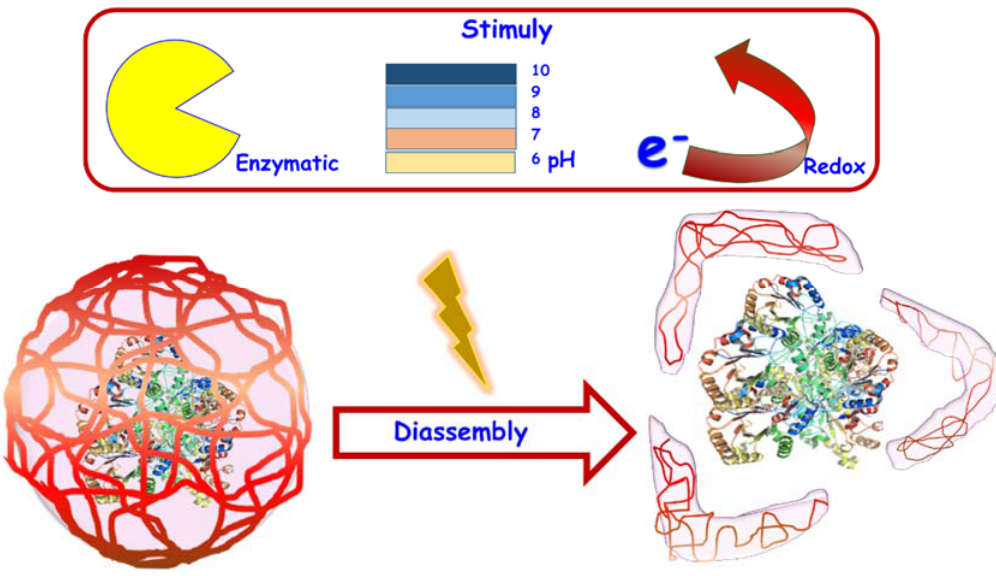
Figure 5. “Stimulation” and “diassembly” of degradable nanocapsules.